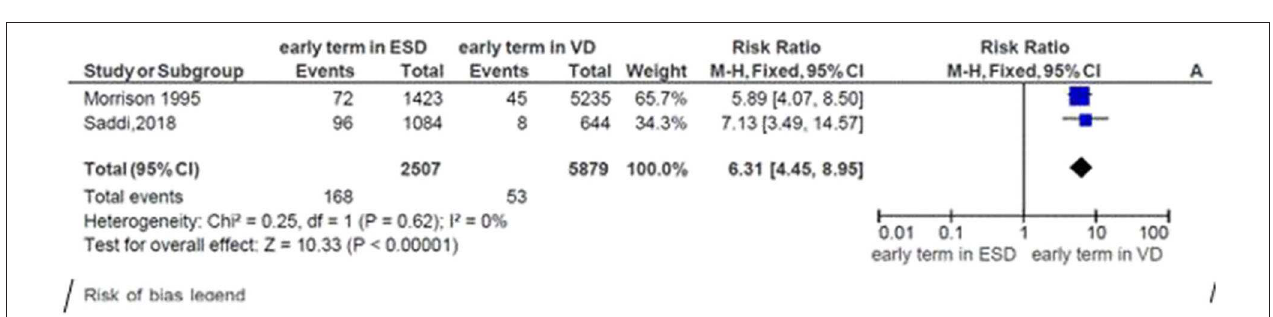
ECS ( RR = 1.12; 95%CI: 0.64–1.18) ( Figure 7